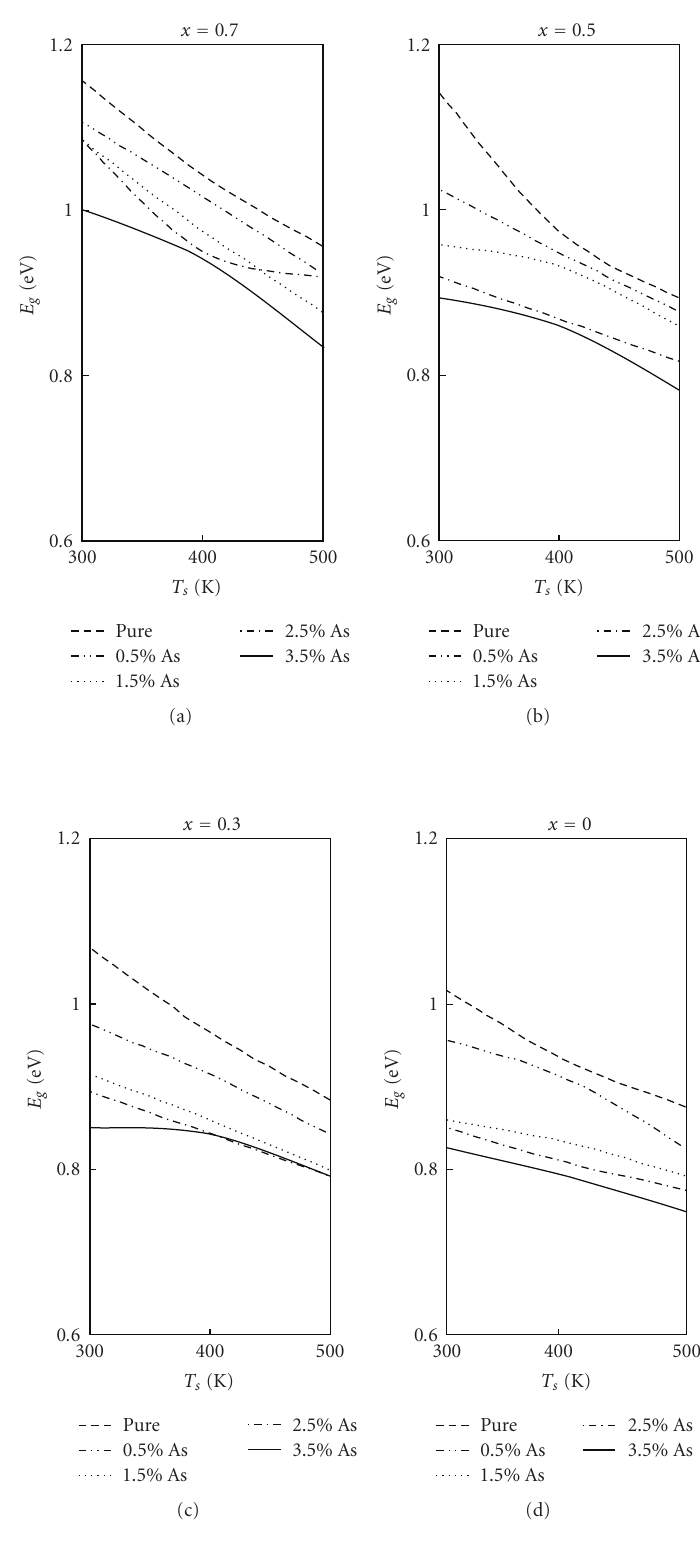
Figure 4: Variation of E g as a function of T s for films deposited with di ff erent values x in pure and doped a-Ge x Si 1 − x :H thin films with various percentage of